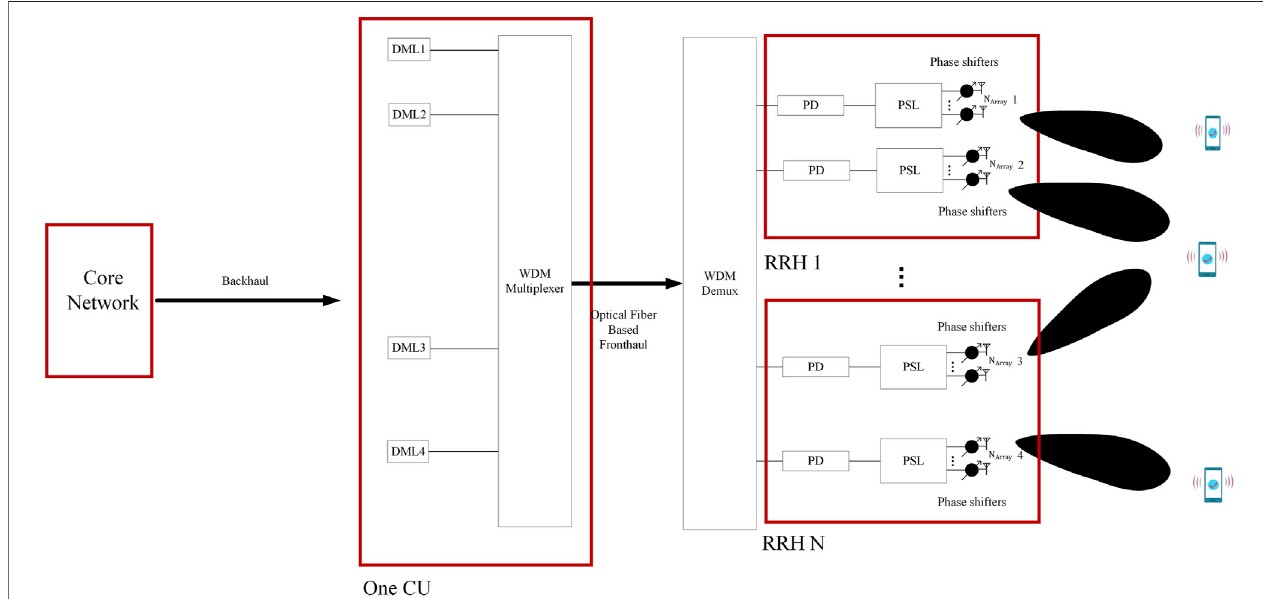
FIGURE 1 | Conventional system model. (PSL: Power Splitter, DML: Directly Modulated Laser, WDM: Wavelength Division Multiplexing, CU: Central Unit, RRH: Remote Radio Head, PD: Photo-detector).